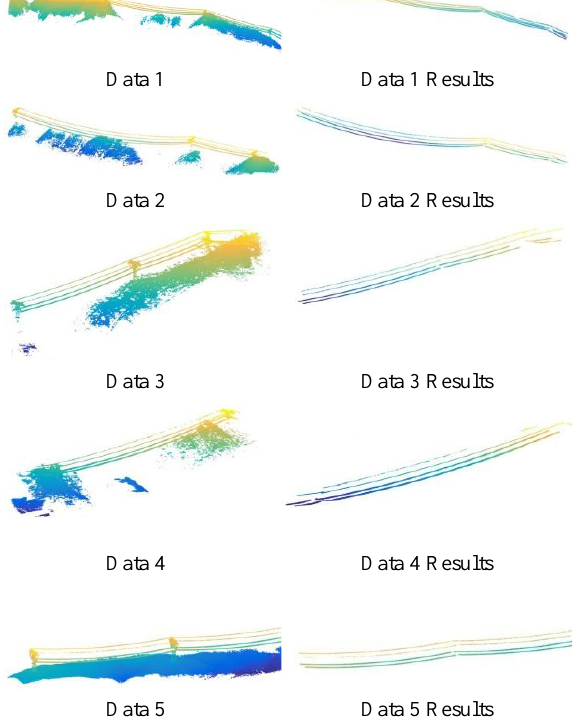
Figure 13. Processing results of the remaining 5 sets of data.